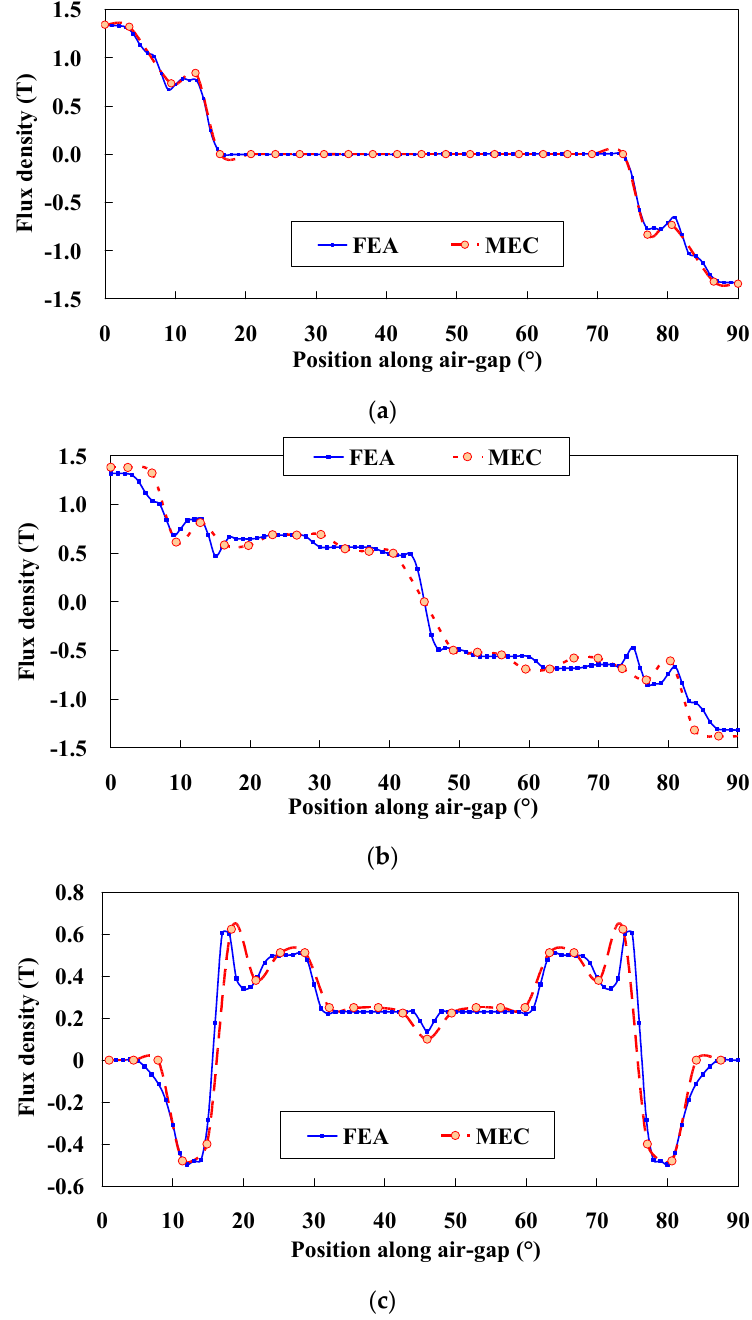
Figure 6. Air-gap flux density distributions: ( a ) by phase-A current; ( b ) by d-axis current; ( c ) by q-axis current.